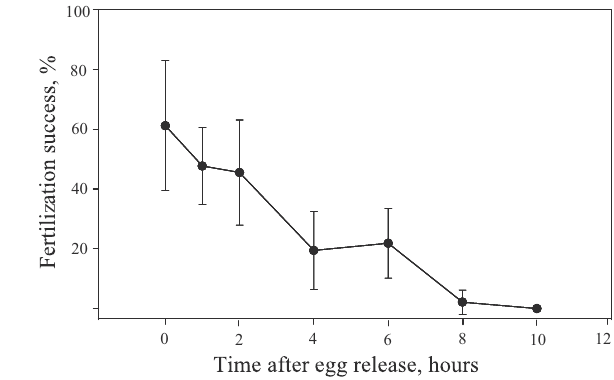
F IG . 4. – The effect of sperm aging on sperm swimming velocity in F IG . 6. – The effect of egg age on fertilization success in Galeolaria Galeolaria caespitosa . Each point represents the average value caespitosa . Each point represents the average value obtained obtained from three separate experiments conducted with 5 individual males. Error bars are SD.